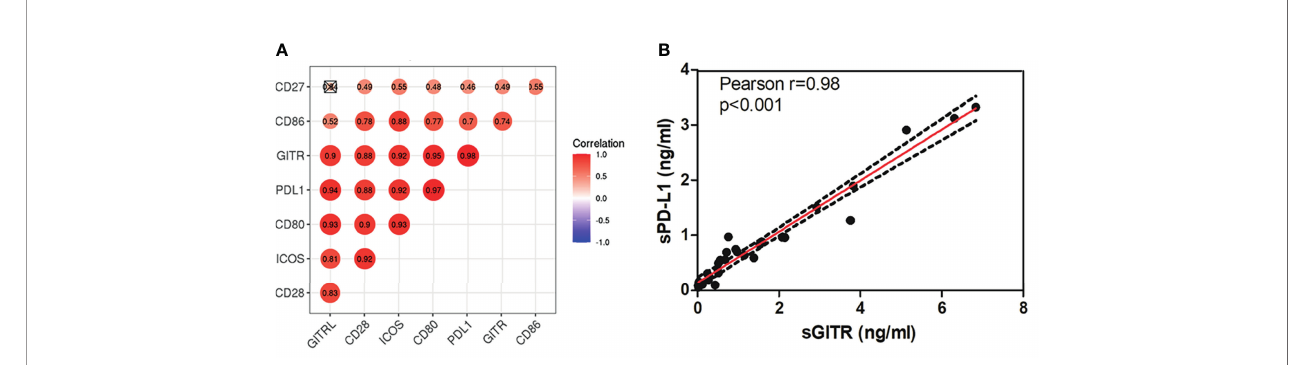
FIGURE 1 | sPD-L1, sCD80, sCD86, sCD28, sGITR, sGITRL, sCD27, and sICOS levels correlated highly with each other in LARC patients. (A) Correlation between baseline plasma sPD-L1, sCD80, sCD86, sCD28, sGITR, sGITRL, sCD27, and sICOS in LARC patients. (B) Correlation between sGITR and sPD-L1